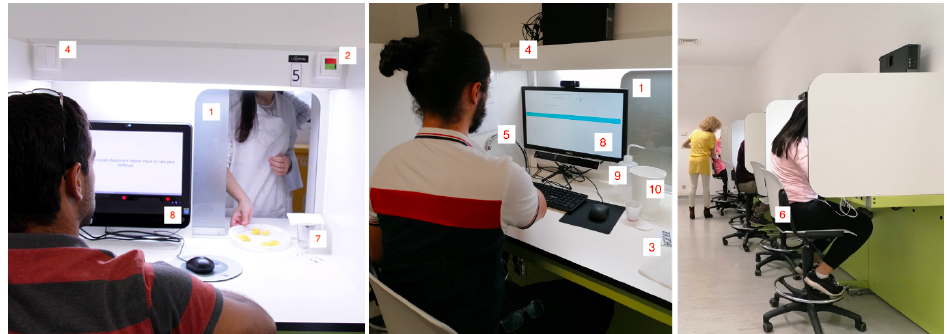
Figure 1. Overall layout of the individual test booths and room for neuroorganoleptic